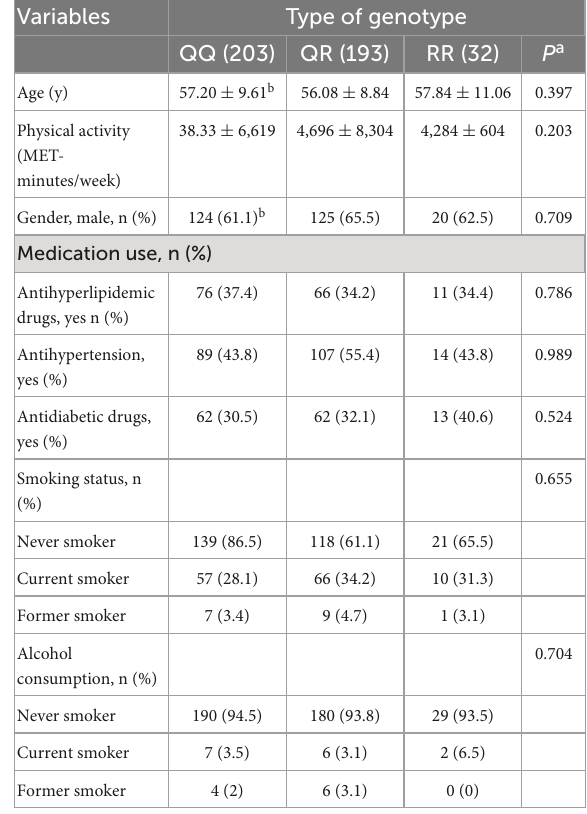
TABLE 1 Characteristics of study participants according to PON1